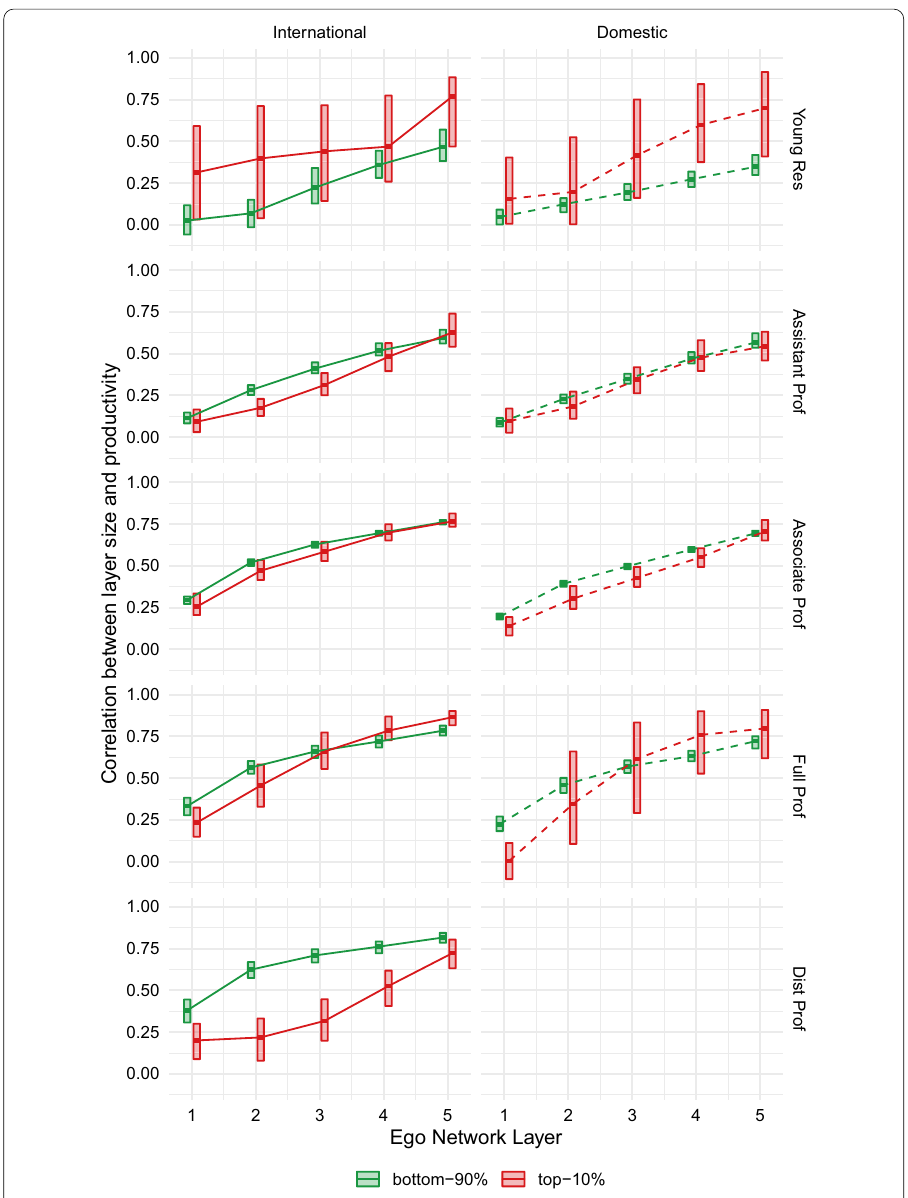
Fig. 14 Highly-mobile researchers: productivity and co-authorship ego networks. Correlation between ego network layer size and numbers of authored publications, for highly mobile authors (red) and regular authors